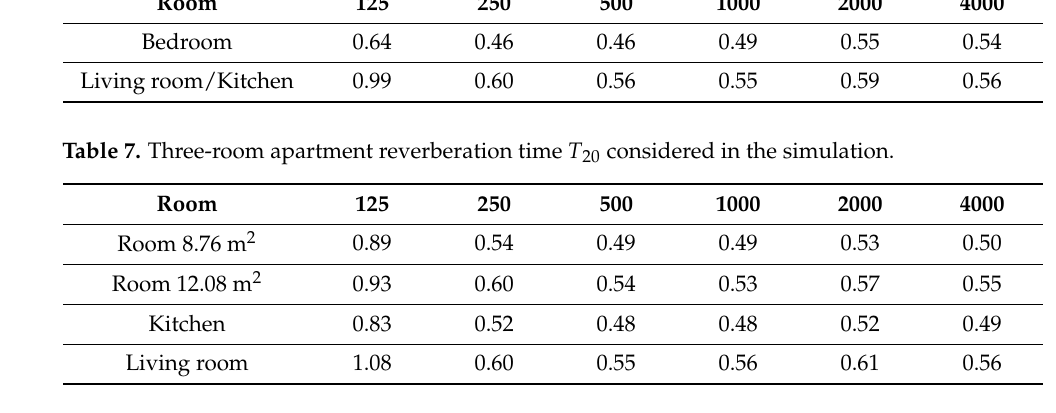
Table 6. Two-room apartment reverberation time T 20 considered in the simulation.